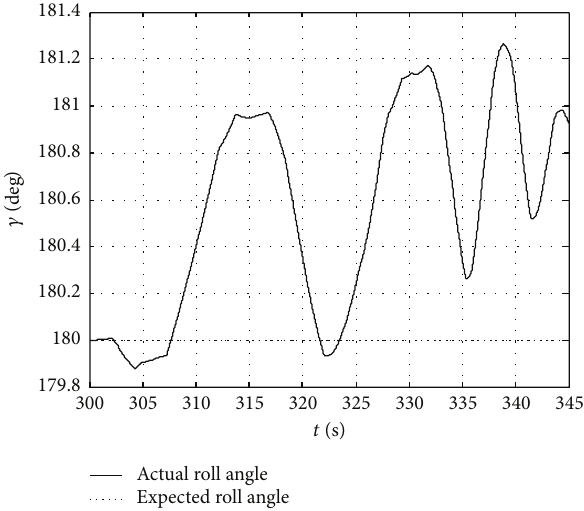
Figure 12: Simulation result of pitch angle.